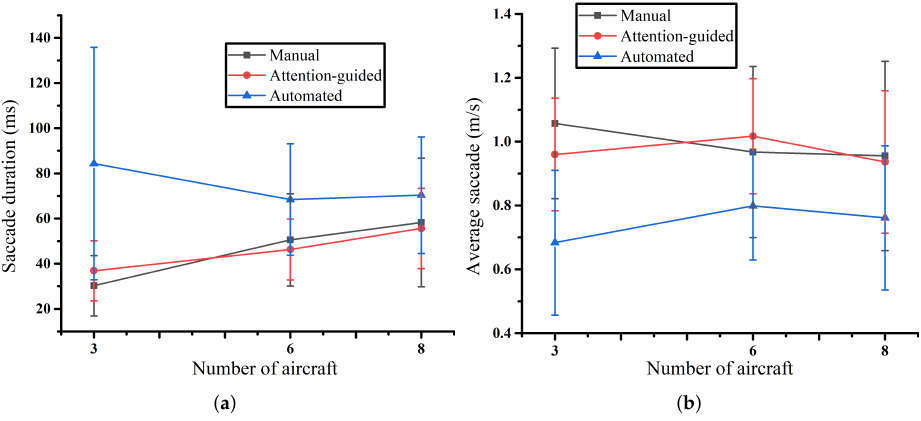
Figure 8. Statistical results on saccade behaviors. ( a ) Saccade duration, ( b ) average